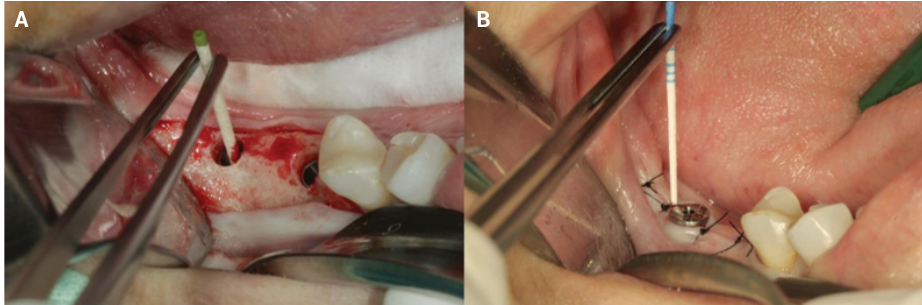
Figure 1. (A): Internal collection at T0, NS group. (B): External collection at T0, located on the periimplant groove, NS